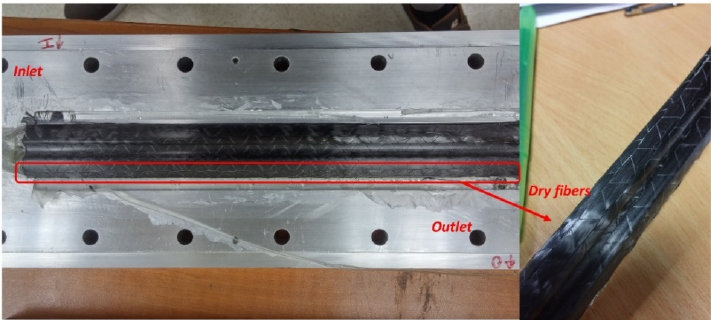
Figure 12. Cured part with process parameters (injection pressure 2 bar and bladder pressure 4 bar) showing unfilled preform at the outlet after the injection time of 22 min.